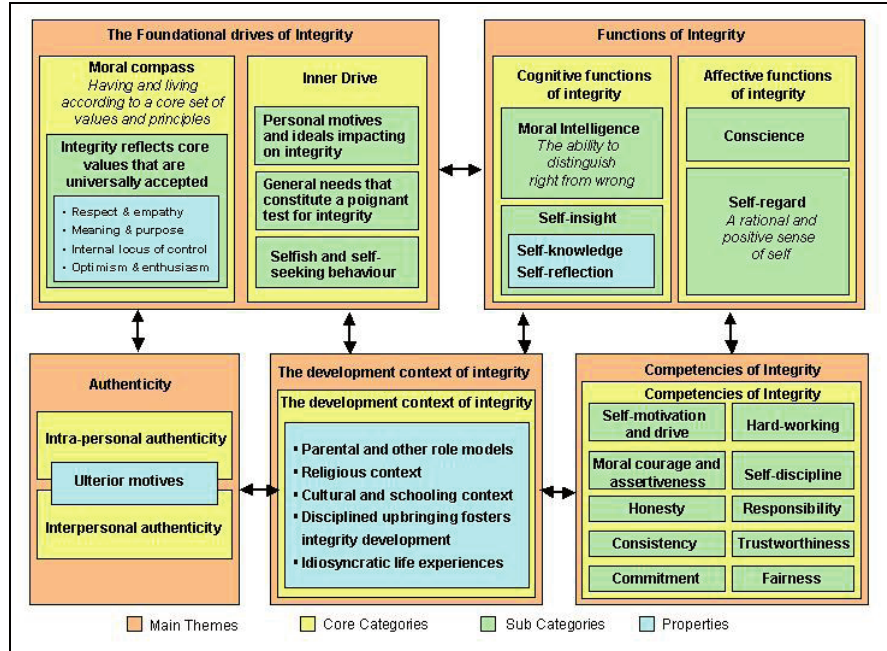
Figure 1 Conceptual framework of integrity and integrity